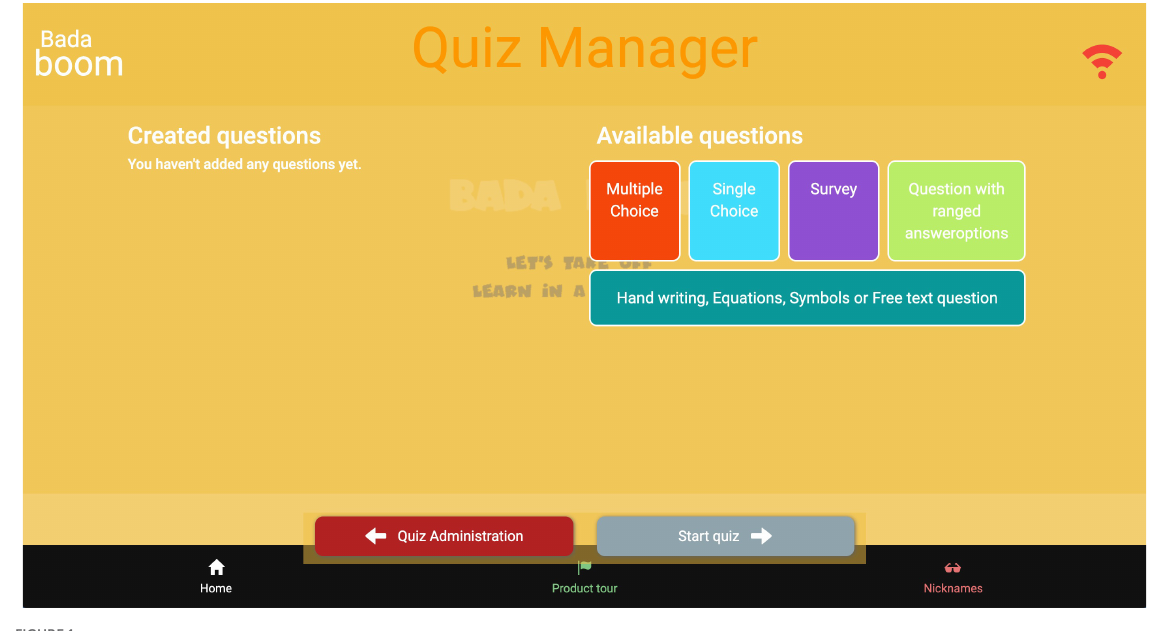
FIGURE1 Hand-writing function in Badaboom! (http://palms.polyu.edu.hk/).